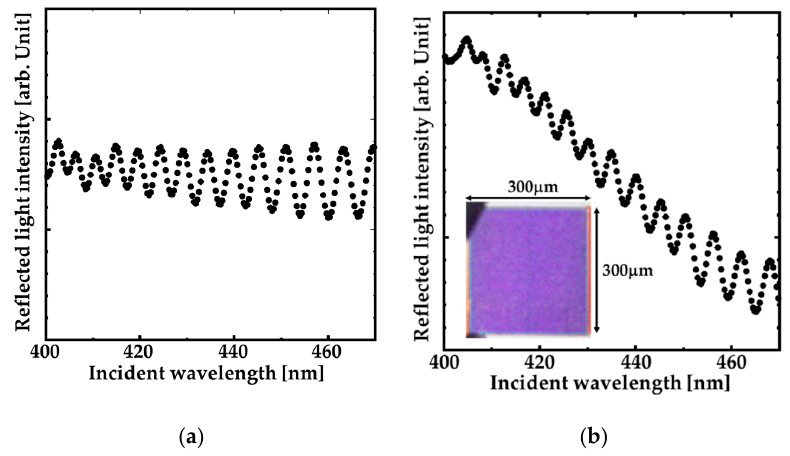
Figure 6. Normal reflection spectrum of: ( a ) GaN-film and ( b ) the fabricated GaN-HCG. The inset shows the optical microscope image of the GaN-HCG region.